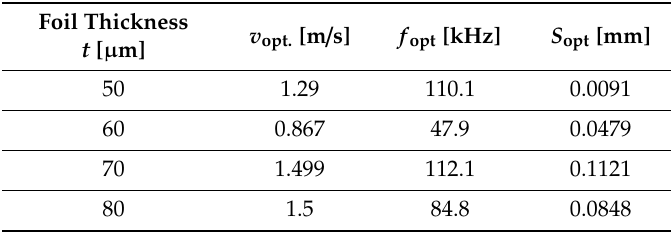
Table 8. Optimal values of decision